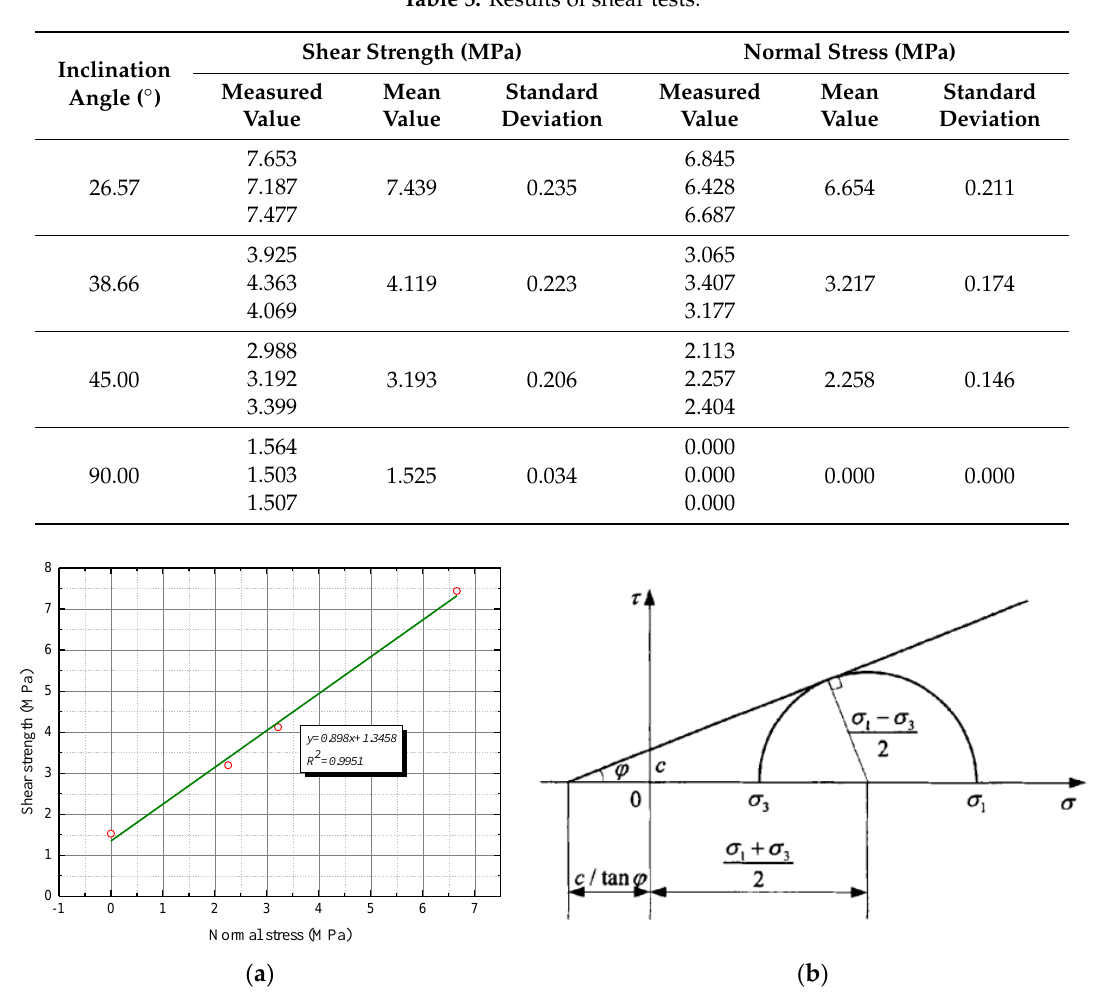
Table 5. Results of shear tests.